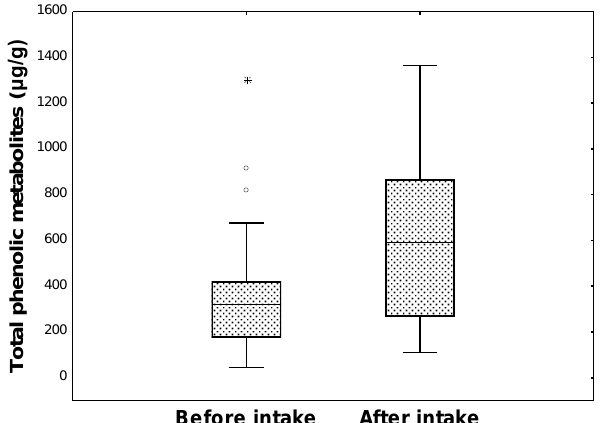
Figure 3. Box and whiskers plots ( _ : median; : 25th–75th percentiles; : non-outlier range; : outliers; : extremes) of the total phenolic metabolites content in the intervention group ( n =